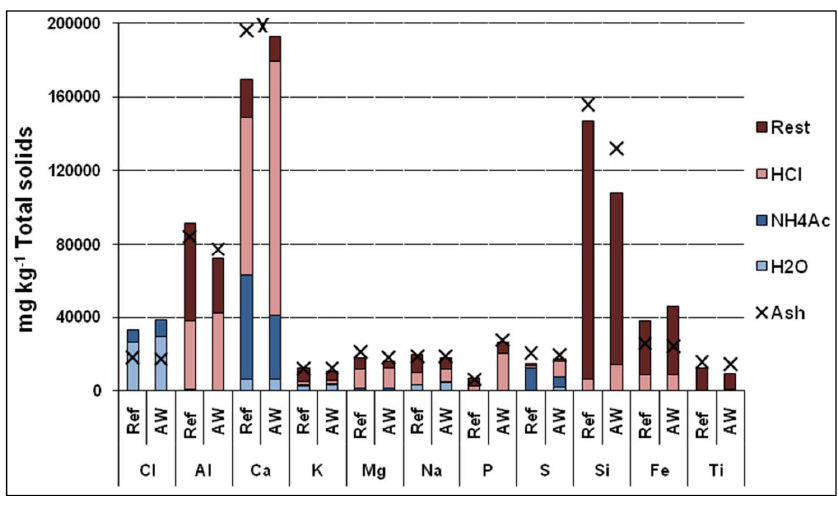
Figure 9. Results of chemical fractionation analysis of cyclone